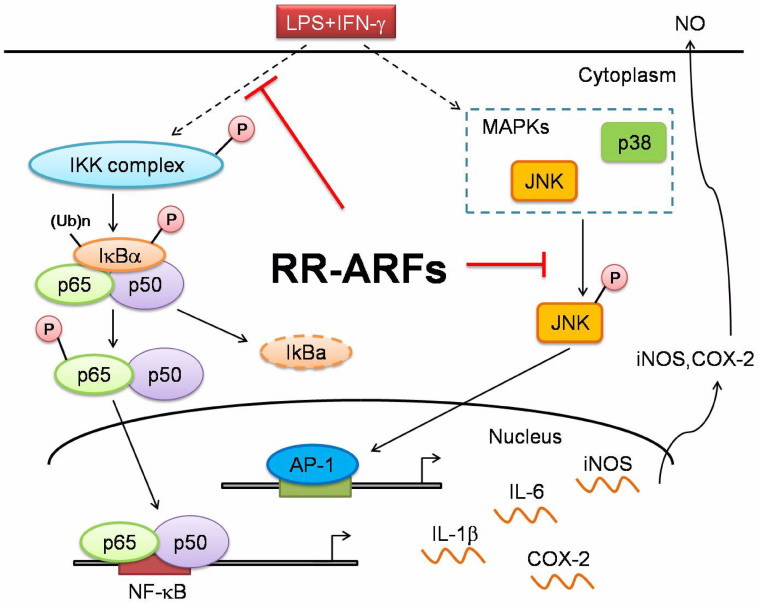
Schematic model showing role of RR-ARFs in inflammatory signaling pathways.RR-ARFs attenuated LPS/IFN-γ-induced inflammatory responses through inhibition of NF-κB, MAPK/JNK activities, respectively, in LPS/IFN-γ-stimulated RAW264.7 cells.